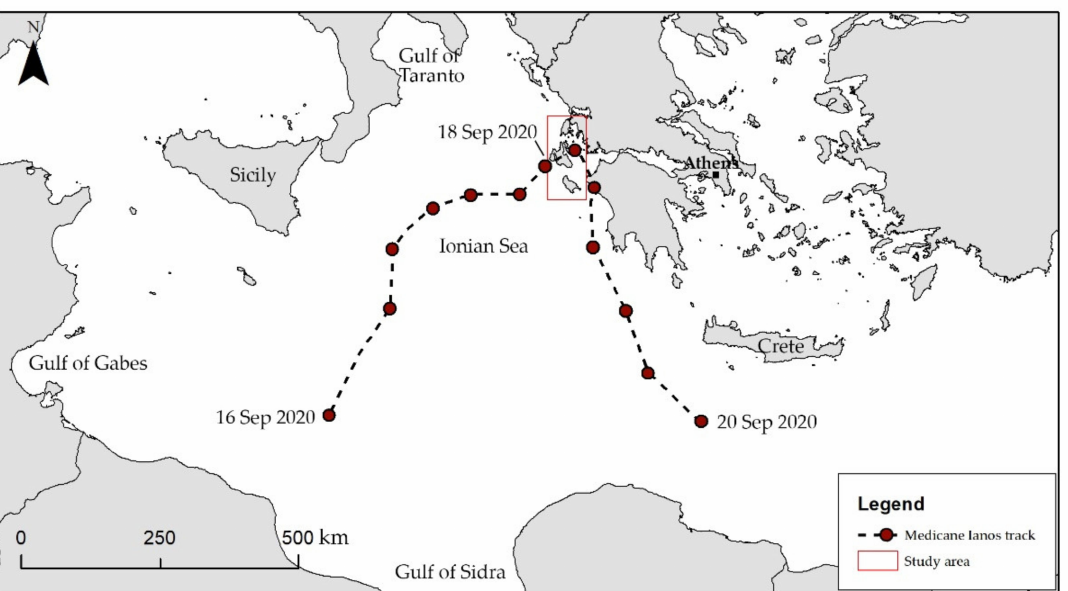
Figure 2. Approximate path of the core Medicane Ianos in the Mediterranean between 16 and 20 September 2020, starting near the Libyan coast, through the Ionian Sea and the study area [68]. Medicane Ianos affected the central and southern parts of the Ionian Islands (Cephalo- nia, Lefkada, Ithaki, and Zakynthos). Local weather stations showed that the maximum rainfall in Western Greece was recorded in Cephalonia and Zakynthos Islands, recording a value of 769 mm and 250 mm, respectively, in 48 h [48,69]. The higher rainfall values ap- peared in the area between northern Cephalonia and Ithaki and southern Lefkada, whereas Zakynthos, northern Lefkada, and southern Cephalonia received smaller amounts [48]. Indicatively, these values are higher than the maximum 24 h rainfall accumulation recorded ever in Cephalonia (that is 192.6 mm in a period of 63 years of continuous measurements) and in Zakynthos (that is 184.8 mm in a period of 43 years of measurements) [70]. The value recorded in Cephalonia is, in fact, close to the average yearly precipitation of the island, calculated at 812.3 mm (Argostoli Station [46]). Ianos also exhibited hurricane-level winds with gusts reaching 54.2 m/s and 42.0 m/s in Cephalonia and Zakynthos, respectively, when all-time records in the area reached a value of 47 m/s [48], showing that both in terms of precipitation and wind speed Ianos was a rare